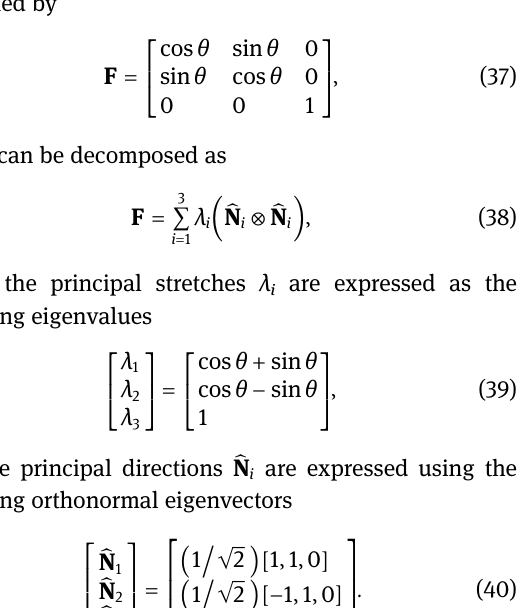
Figure 11: (a) and (b) Affine transformation deforming asymmetric double gyroid to strained asymmetric double gyroid. (c) Band structure exhibiting Weyl points. Reproduced with permission from ref. [29]. Copyright 2018, National Academy of Sciences (a) –